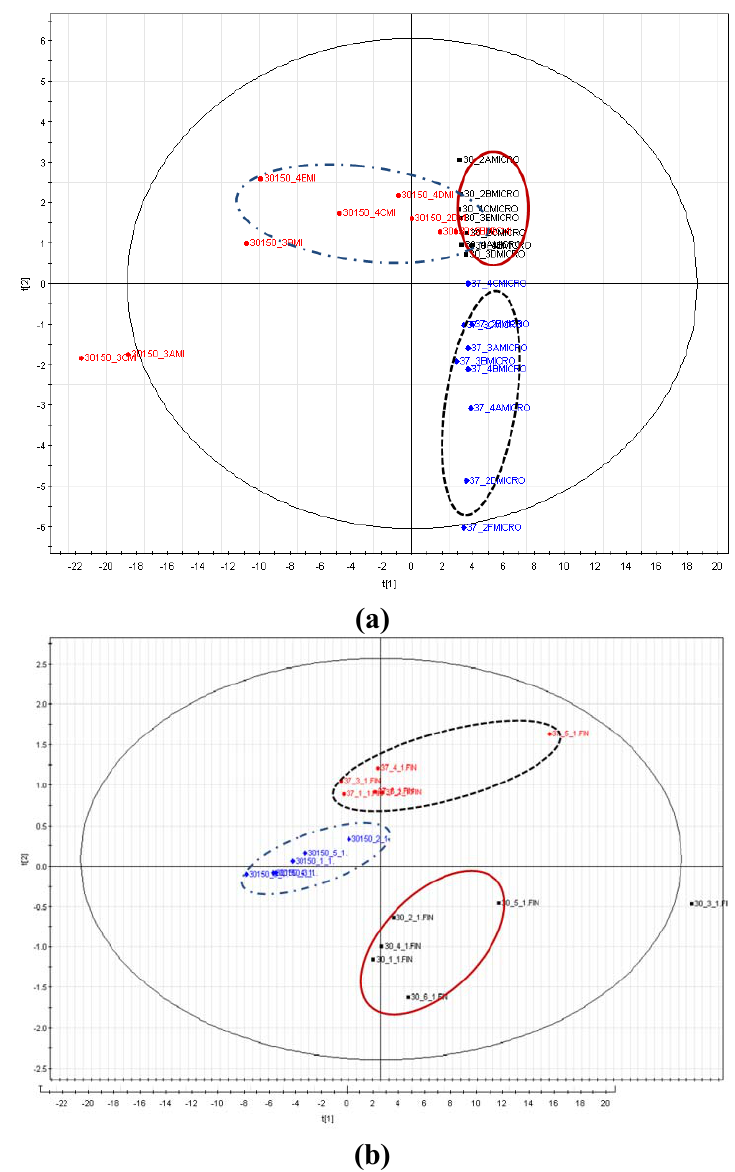
Figure 6. ( a ) PLS-DA score plots by the combination of PC1 and PC2 of TMS derivatised replicates. The ellipses represent confidences of 95% in the Hotelling T2 tests. 30 represents condition of 30 °C, 37 represents condition of 37 °C, 30150 represents condition with agitation (150 rpm). ( b ) PLS-DA score plots by the combination of PC1 and PC2 of MCF derivatised replicates. The ellipses represent confidences of 95% in the Hotelling T2 tests. 30 represents condition of 30 °C, 37 represents condition of 37 °C, 30150 represents condition with agitation (150 rpm). ( c ) Hierarchical clustering analysis of MCF derivatised metabolites according to conditions. Red represents condition of 30 °C, blue represents the condition of agitation and black represents the condition of 37